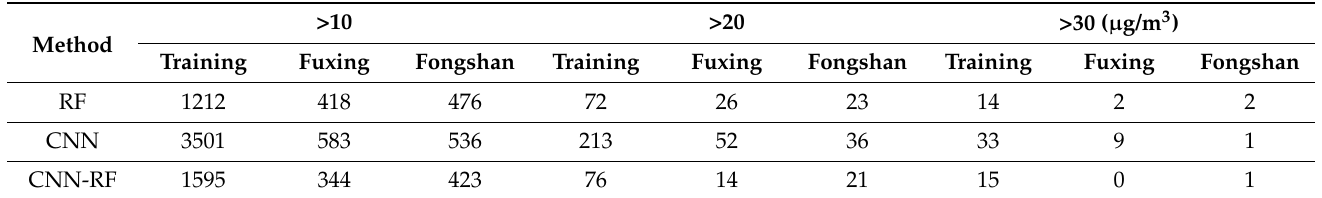
Table 6. Excess residuals by model.